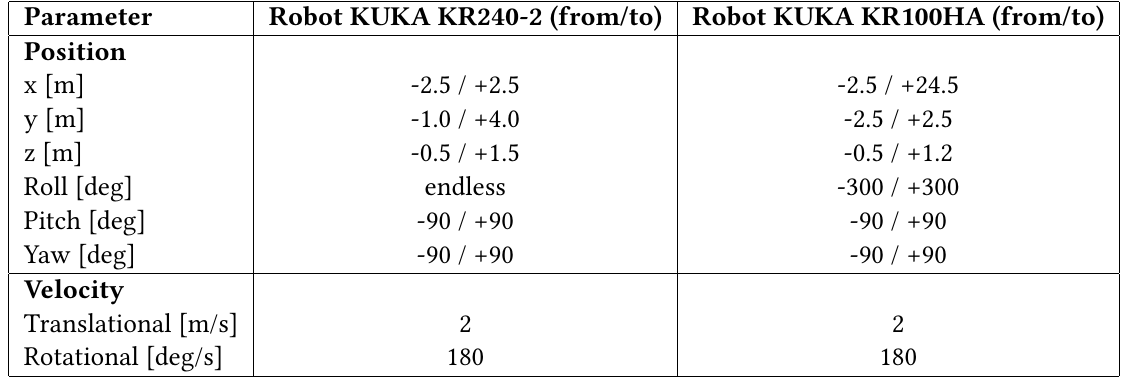
Table 3: Motion ranges of the robots of the EPOS facility with respect to the Global / Lab Coordinate